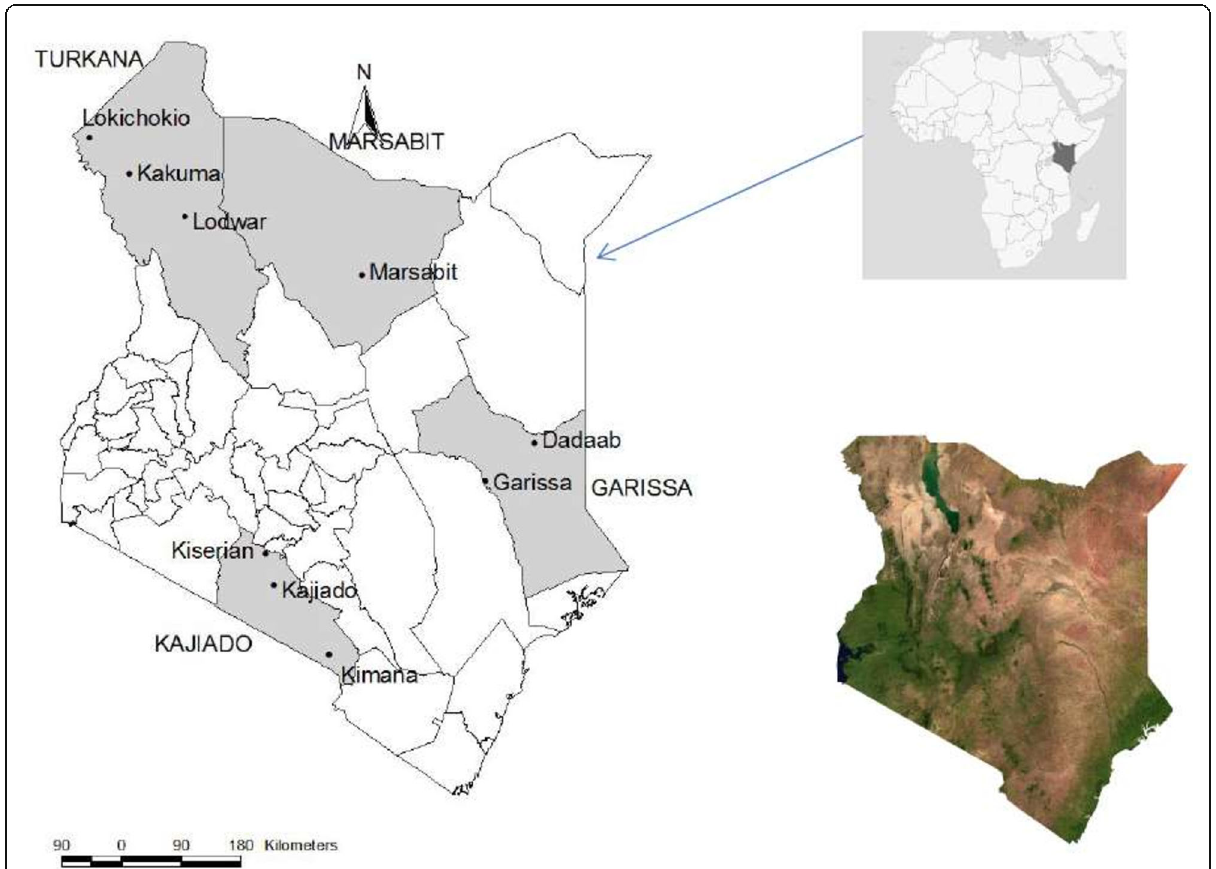
Fig. 2 Map of Kenya showing the study area and vegetation